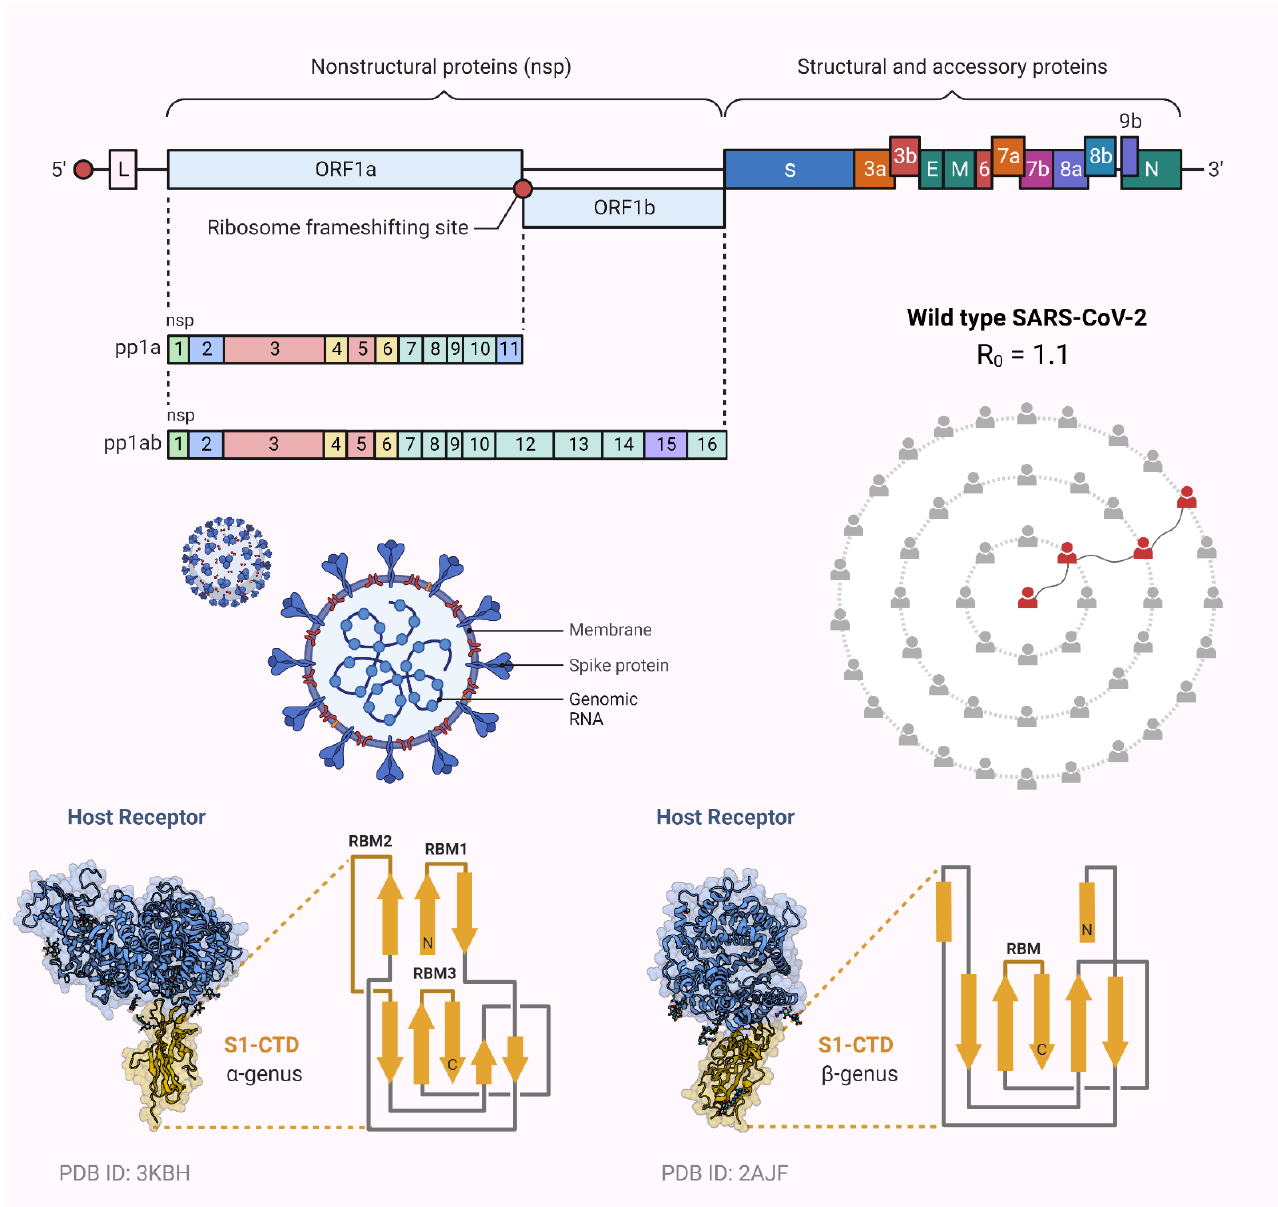
Figure 2. Schematic diagrams of the SARS-CoV-2 genome with structure. Reproduction number of wild-type SARS-CoV-2 is 1.1 which is still higher in the emerging variants of SARS-CoV-2. The re- ceptor-binding motif mainly interacts with host receptor for viral host entry (created with Bioren- der.Com).